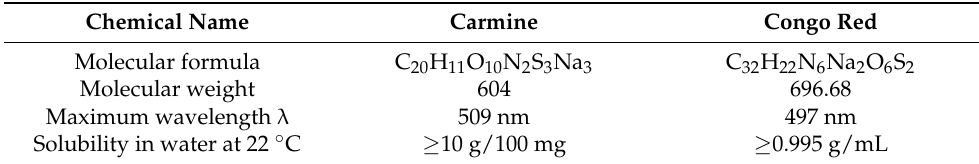
Table 1. Chemical properties of carmine and Congo